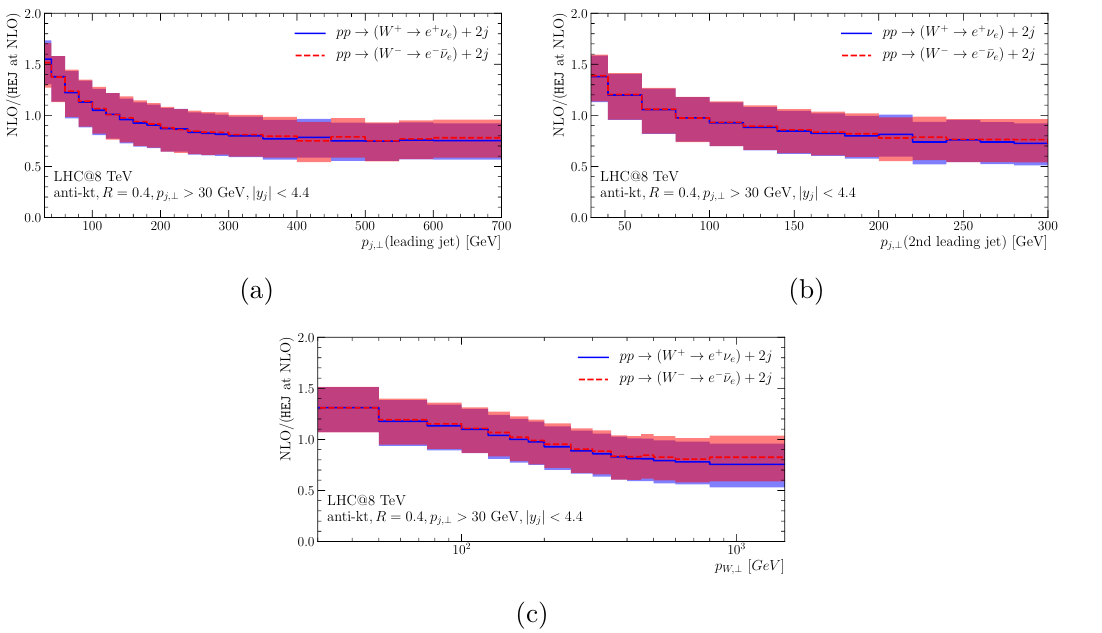
Figure 16. The NLO matching corrections for the following distributions presented in ref. [30] for inclusive W + + 2 j production (blue, solid) and W − + 2 j production (red, dashed): (a) transverse momentum of the leading jet, (b) transverse momentum of the second jet and (c) the transverse momentum of the W